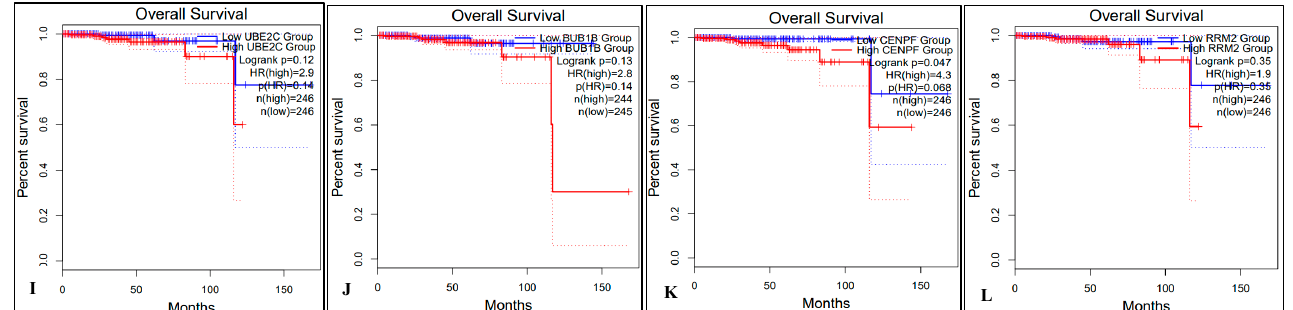
Figure 8. Prognostic survival analysis of the overall survival (OS) based on the high or low expression of 12 hub genes from TCGA in PCa patients, using the GEPIA online tool. OS analysis for 5 up-regulated ( A – E ) and 7 down-regulated ( F – L ) genes is presented. The dotted line on both sides of the curve represents the 95% confidence interval (95% CI), and log-rank p < 0.05 is considered as a statistically significant value. The red and blue lines represent high and low expressions of individual Hub genes ( A – L ), respectively in the PCa patient samples compared to the normal tissues.